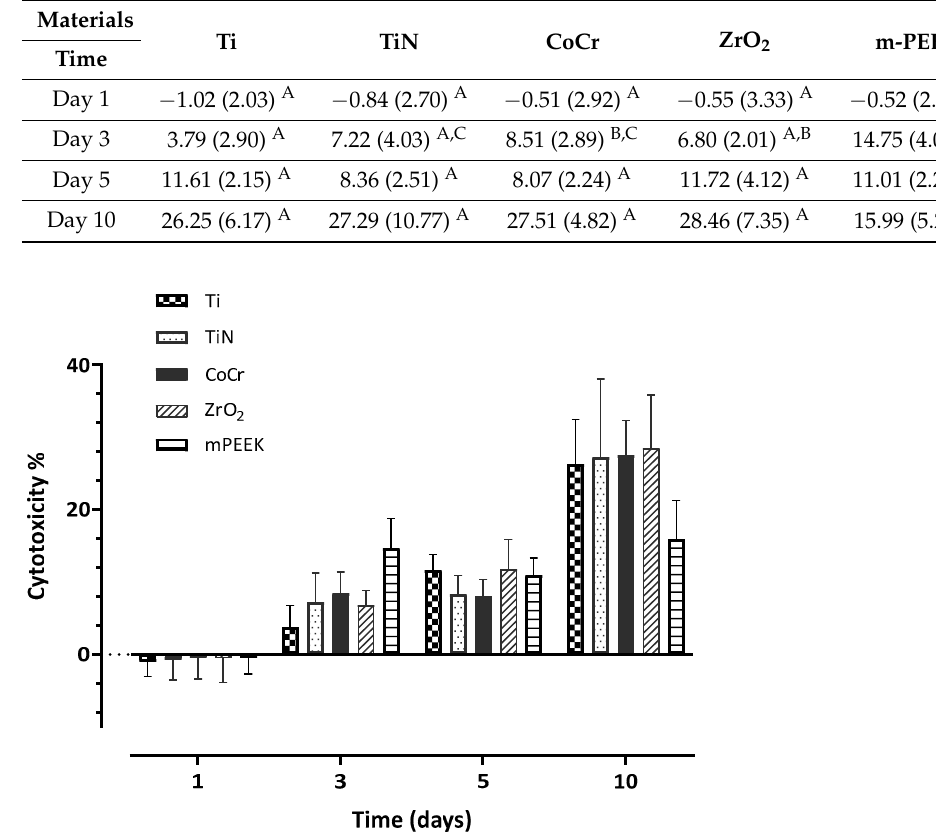
Figure 6. A bar chart illustrating the mean values of cell cytotoxicity percentage at days 1, 3, 5, and 10 for HGKC. Error bars represent the standard deviation. Table 5. The mean and standard deviation values of HGFB cell cytotoxicity percentage at days 1, 3, 5, and 10. Means with the same letters are not statistically different ( p > 0.05).